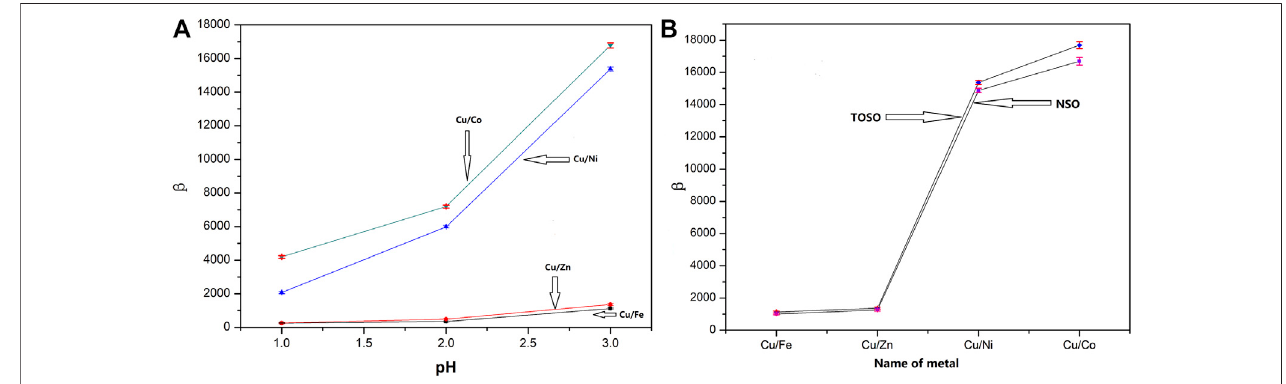
FIGURE 3 | Selectivity of TOSO and NSO for Cu 2+ /metal ion in H 2 SO 4 medium. (A) Selectivity of TOSO; (B) selectivity of TOSO and NSO at pH 3.